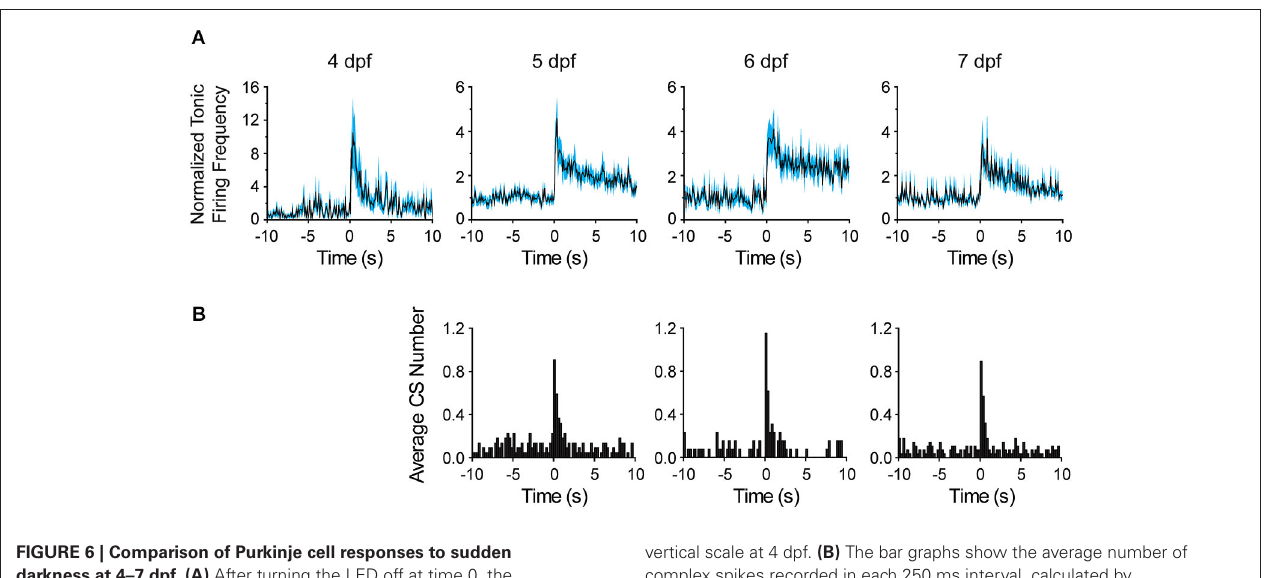
FIGURE 6 | Comparison of Purkinje cell responses to sudden darkness at 4–7 dpf. (A) After turning the LED off at time 0, the frequency of tonic firing was calculated for each 100 ms interval and normalized to the average frequency calculated over the 10 s period prior to the stimulus (solid lines, n = 6–14 cells, 5–11 animals). The cyan-shaded areas represent the SEM. Please note compressed